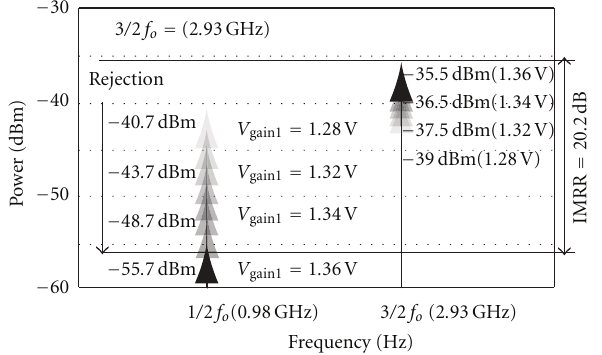
Figure 9: Spectrum of combiner output including 3 / 2 f 0 and 1 / 2 f 0 frequencies. The spurious rejection is performed by the high-pass filter and the variable gain combiner.